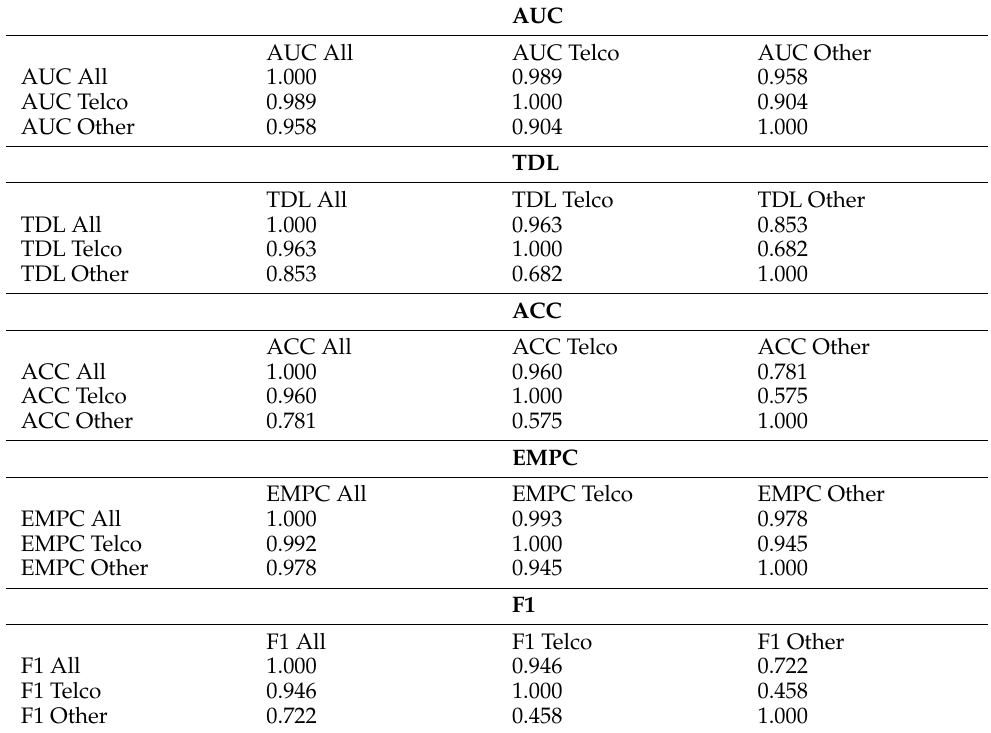
Table 7. Correlation of classifier rankings for each performance metric across all data sets (All), telecommunications data sets (Telco), and other remaining data sets (Other).